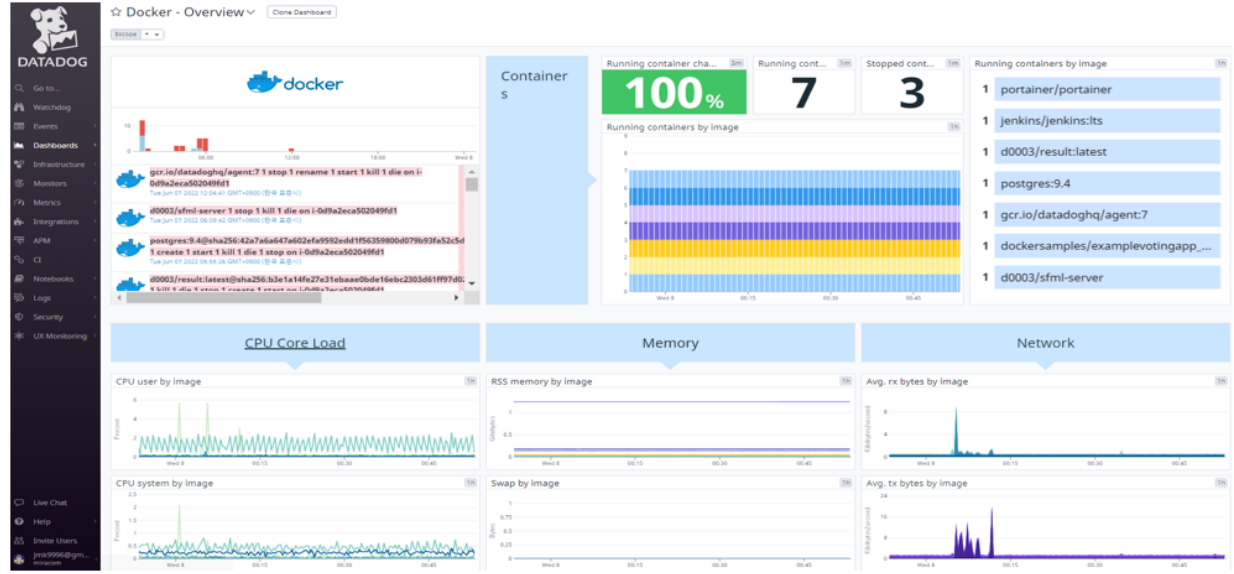
Figure 13. Cloud Docker based monitoring